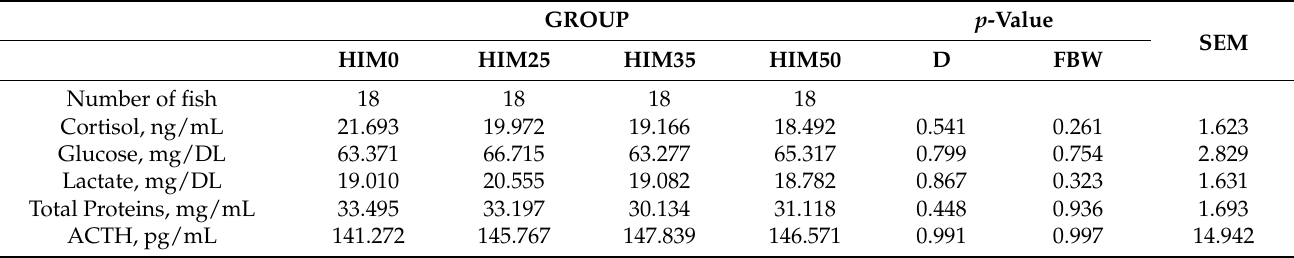
Table 4. Stress parameters of gilthead seabream fed the experimental diets.